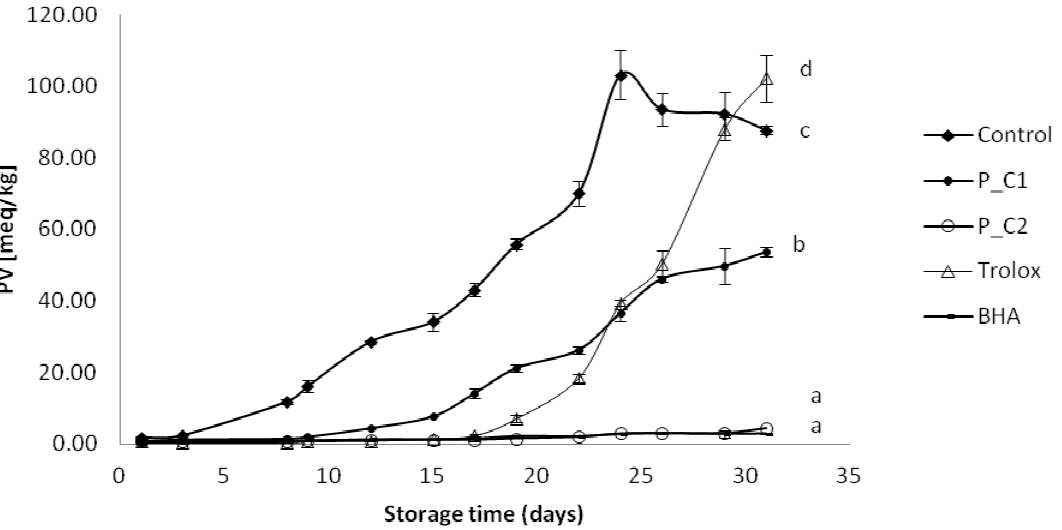
Figure 1. Evolution of primary oxidation (peroxide value) in model food system (O/W emulsion 10% of oil) with different concentration of perilla ethanolic extracts (C1: 80 ppm and C2: 320